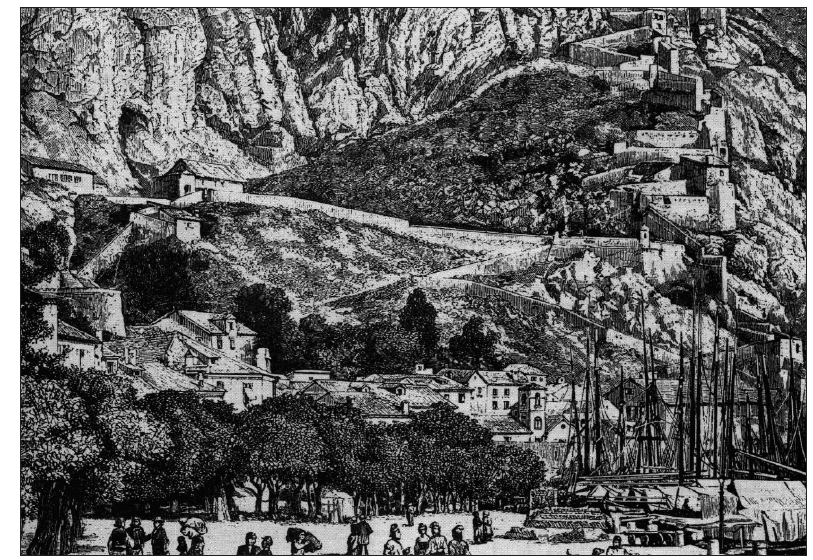
Fig. 5. The walls of Cattaro/Kotor in a 19th century